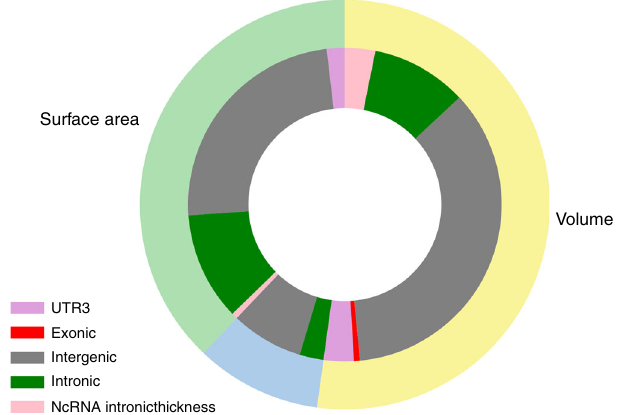
Fig. 3 Functional annotation categories for global and regional CTh, CSA, and CV. Proportion of functional annotation categories for global and regional cortical thickness (blue), surface area (light green), and volume (yellow) assigned by